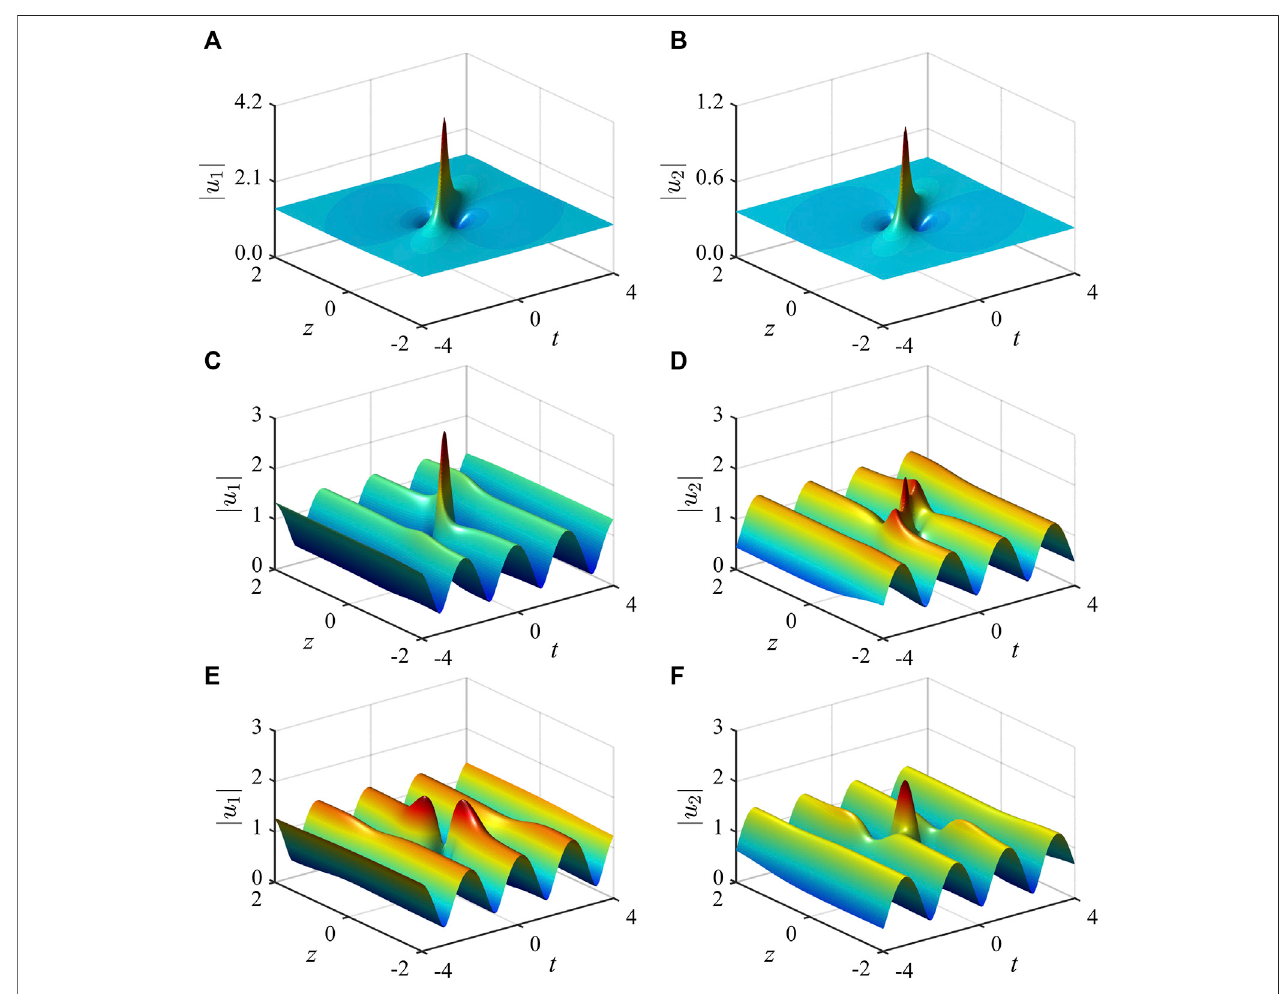
FIGURE 1 | Peregrine soliton states formed on (A),(B) the cw backgrounds when δ (cid:2) 0 and (C) – (F) the periodic-wave backgrounds when δ ≠ 0, in the anomalous dispersionregime( σ (cid:2) 1),underthesameparameters a 1 (cid:2)